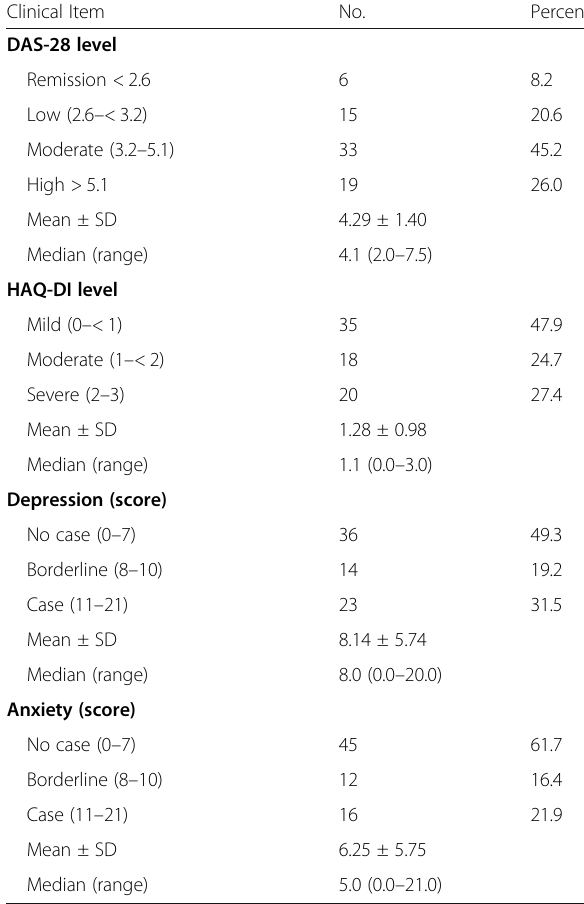
Table 4 Clinical data of the studied patients (No. =